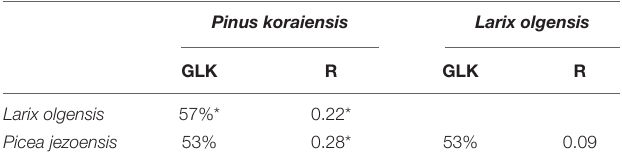
TABLE 2 | Gleichläufigkeit indices (GLK) and Pearson correlation coefficients (R) among the three